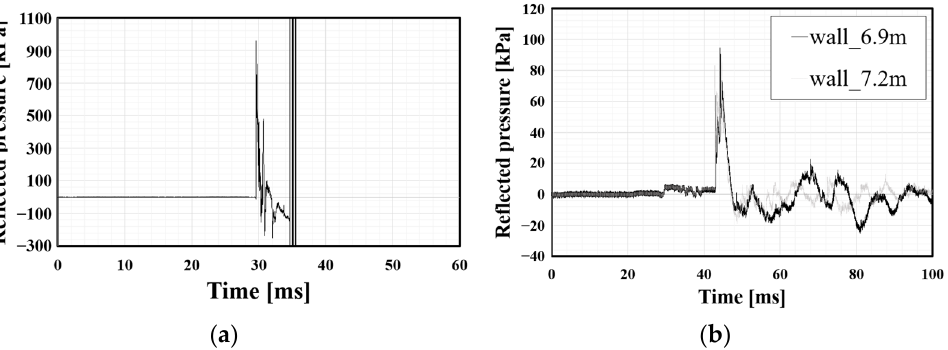
Figure 8. Reflected pressures induced by the hydrogen tank explosion: ( a ) at passenger car; ( b ) at concrete walls.